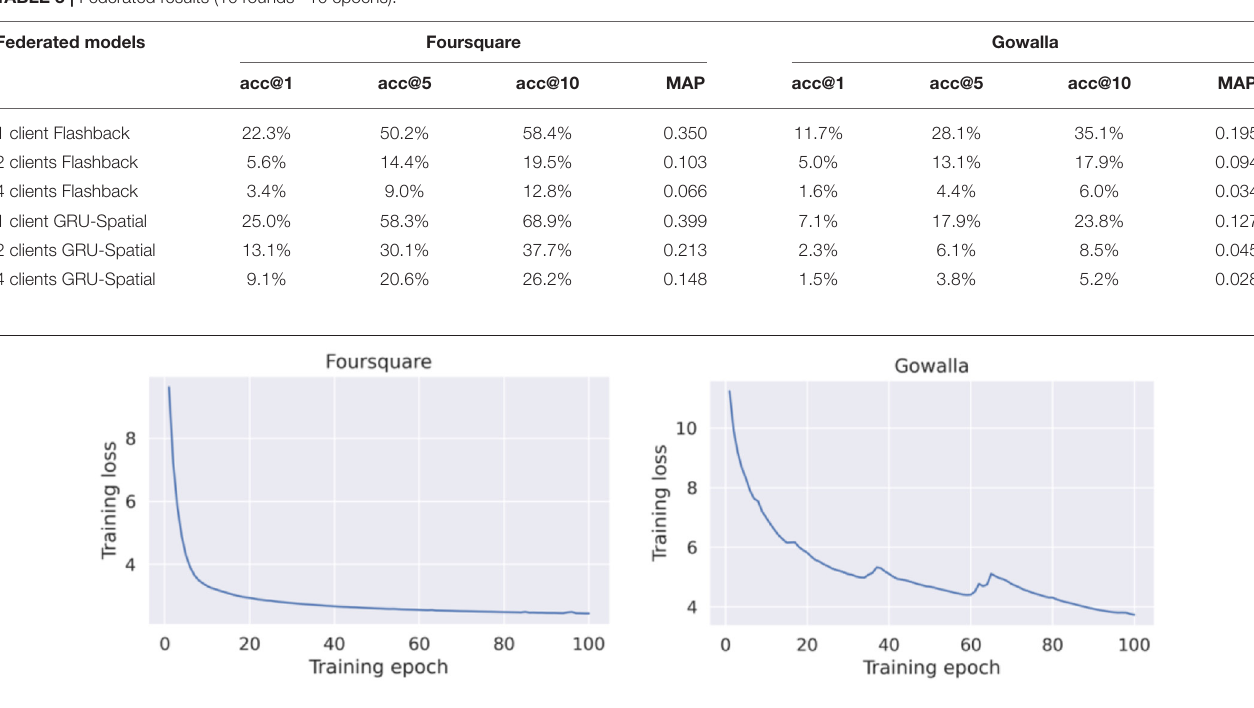
FIGURE 4 | Training loss of the centralized GRU-spatial model.